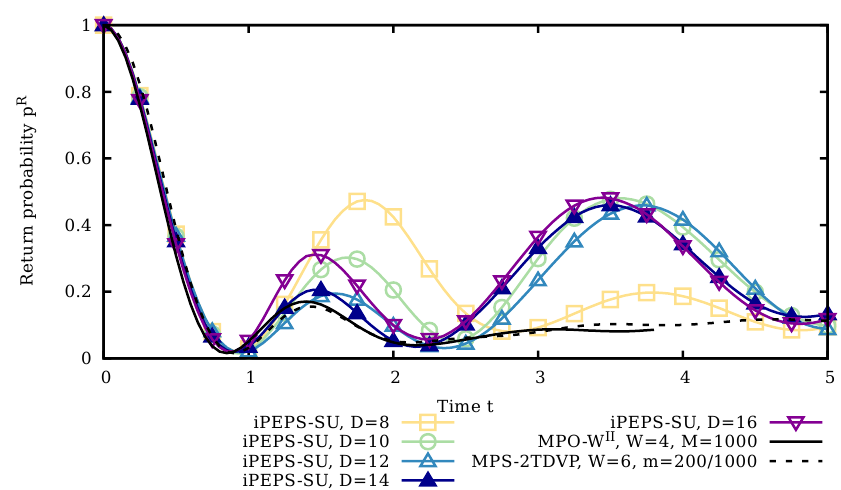
Figure 5: Same as Fig. 3 for longer times t ≥ 1. The return probability shows quali- tative features common to all calculations at large bond dimensions, but quantitative convergence is difficult. The revival around t ≈ 3.5 is not expected and likely due to limited entanglement in our